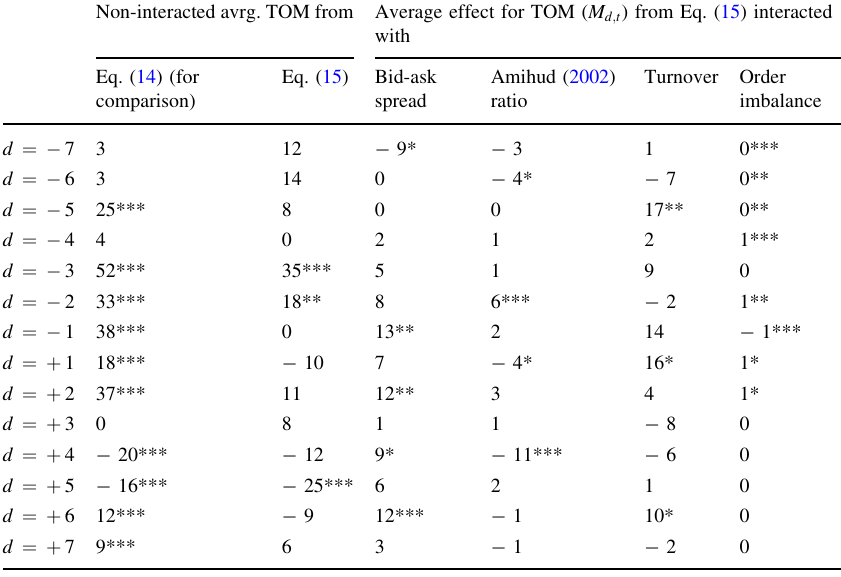
Table 4 Effects of liquidity and order imbalance on returns, part 1: Turn of the month effect Non-interacted avrg. TOM from Average effect for TOM ( M d ; t ) from Eq. (15) interacted with Eq. (14) (for Eq. comparison)